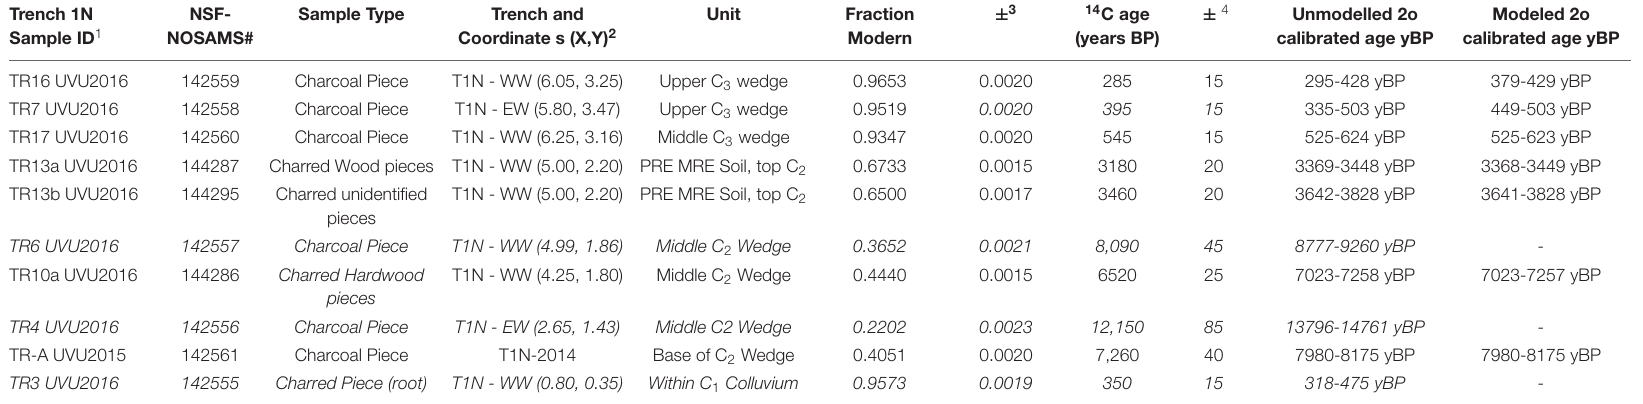
TABLE 1 | T1N radiocarbon data arranged by stratigraphic order.